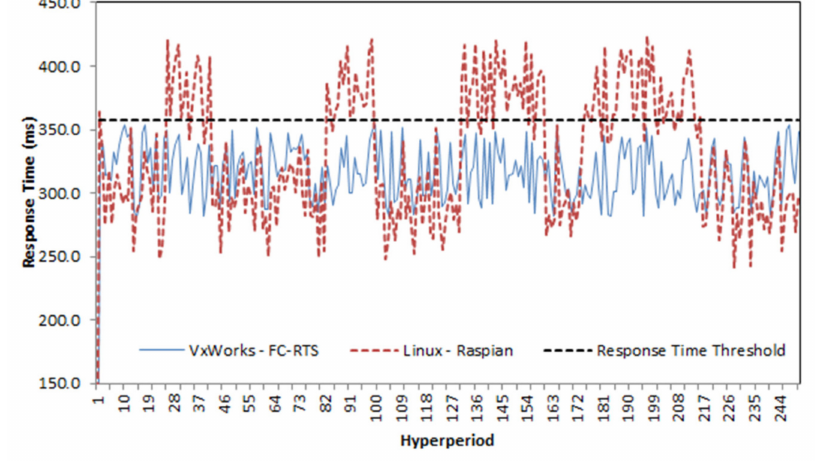
Figure 12. Response time nominal.